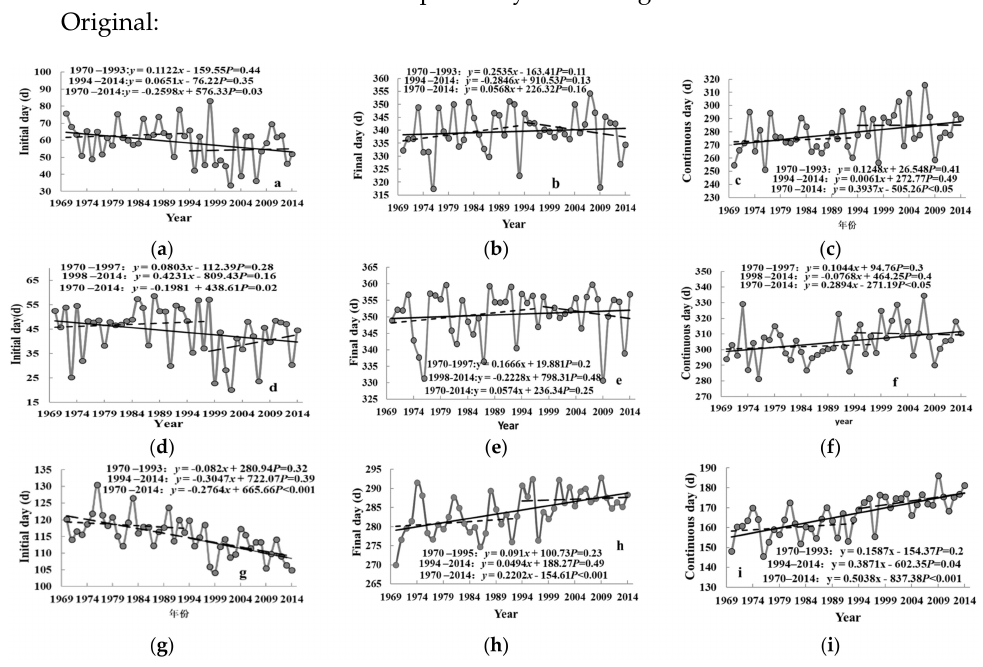
Figure 9. Interannual variation characteristics of the initial day, the final day, and the continuous days of an accumulated temperature of ≥ 5 ◦ C in the northern subtropical zone ( a – c ), mid-subtropical zone ( d – f ), and plateau climate zone ( g – i ) of the Yangtze River Basin during